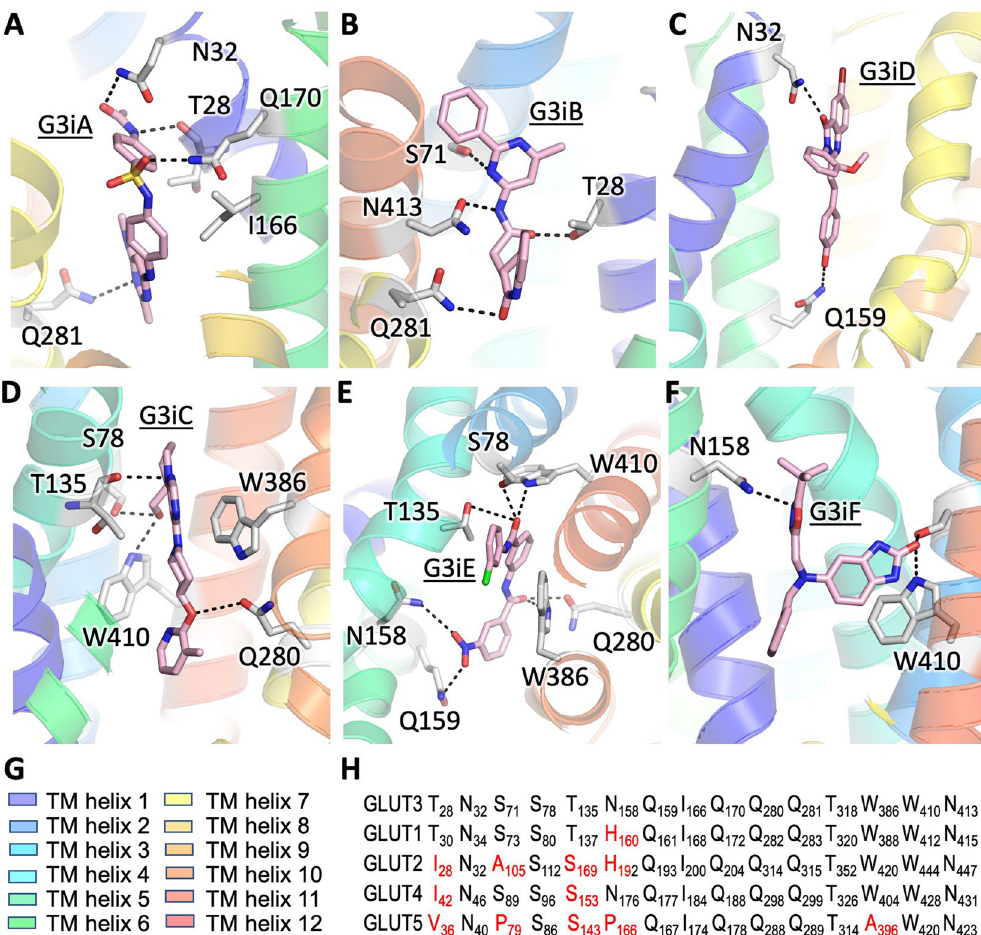
Figure 4. Docking sites of G3iA-G3iF in GLUT3 models. All GLUT3 inhibitors docked in the substrate binding site of the transporter, either to the outward-facing (A–C) , or inward-facing (D-F) conformations. GLUT3 inhibitors (pink color), G3iA (A) , G3iB (B) , G3iC (D) , G3iD (C) , G3iE (E) , and G3iF (F) , and the interacting protein residues (grey color) are shown as stick models. Dashed black lines indicate hydrogen-bond interactions. (G) Color-code for the transmembrane helices (same as in Fig. 1). (H) Sequence alignment among GLUT1-5, for the protein residues interacting with GLUT3 inhibitors. Substitutions of GLUT3 residues in the other GLUT sequences are indicated in red. The figures were generated with Pymol (https:// www. pymol.